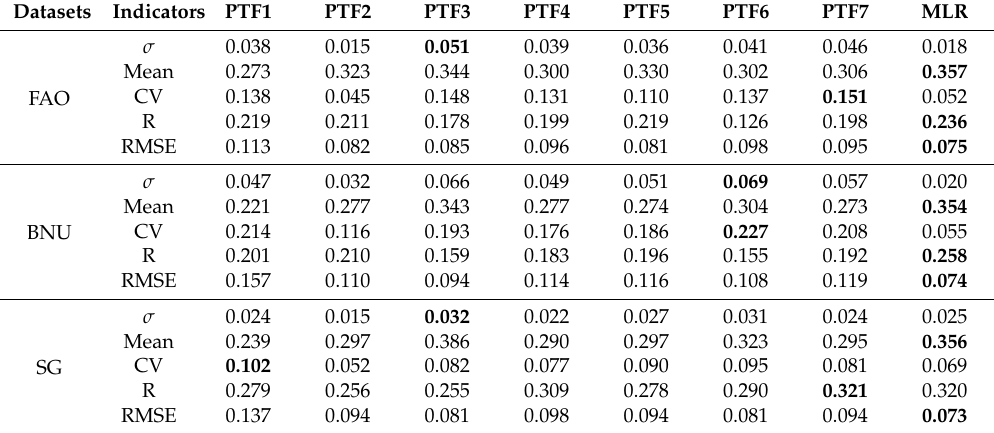
Table 2. Evaluation statistical indicators for 24 groups of ensemble members. Bold text indicates the best behavior among each dataset. MLR represents multiple linear regression field